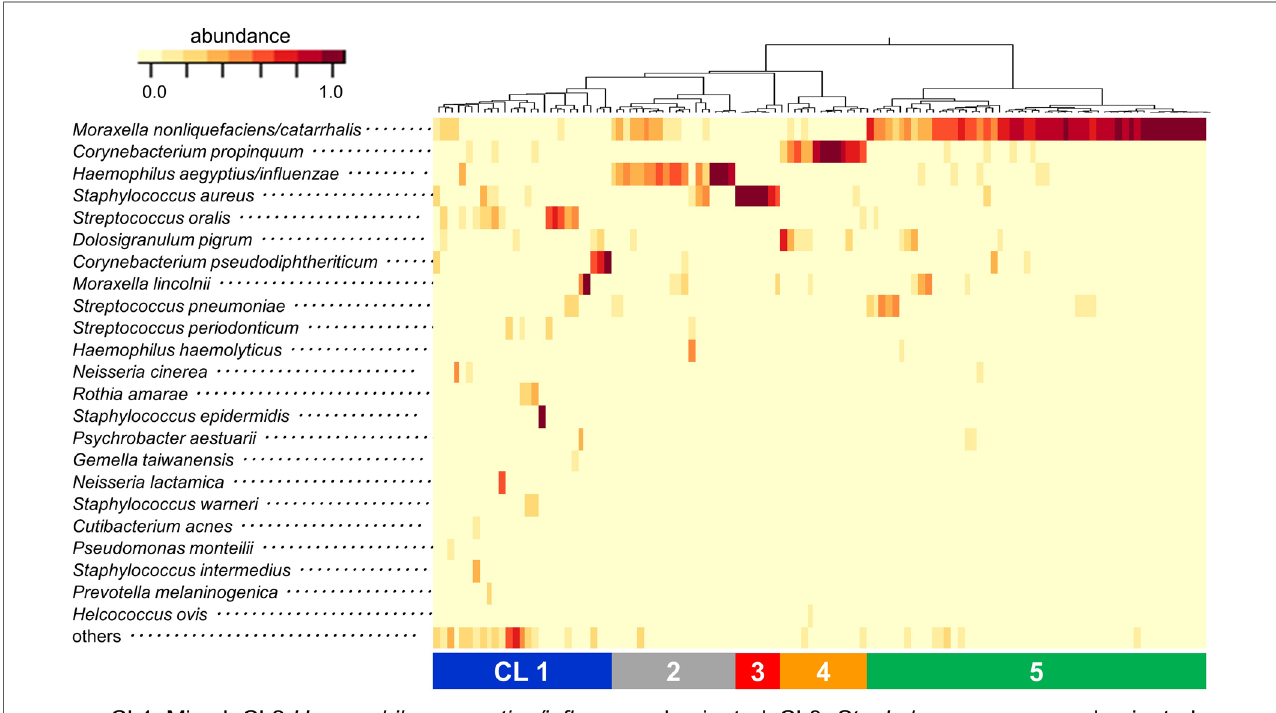
FIGURE 2 Results of clustering analysis at the species level. The relative abundance of all bacteria in each sample and the clustering results based on the composition of the bacteria are indicated by the heatmap. Clustering of samples revealed 5 distinct clusters: CL1) Mixed, CL2) Haemophilus aegyptius/in fl uenzae -dominated, CL3) Staphylococcus aureus- dominated, CL4) Corynebacterium propinquum -dominated and CL5) Moraxella catarrhalis/nonliquefaciens -dominated. CL: